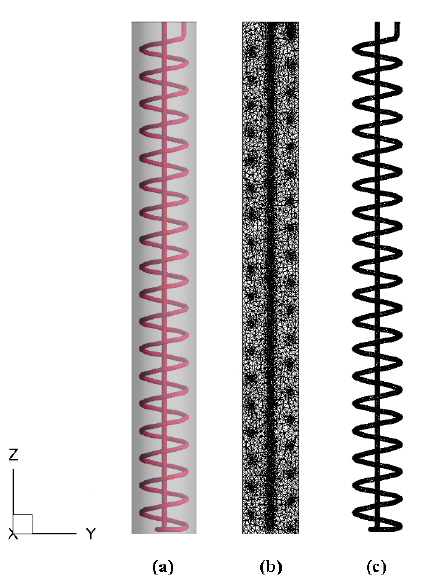
Figure 6. Geometry and mesh results of the TES unit. ( a ) 3D geometry; ( b ) Internal mesh results; ( c ) Helical coil heat exchanger.